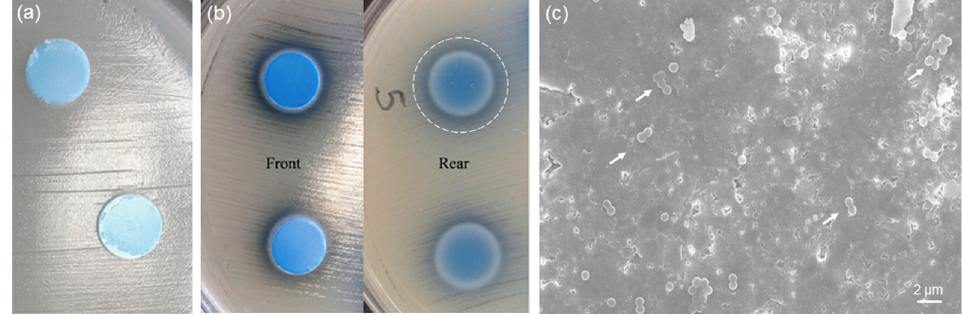
Figure 7. In vitro antibacterial experiments (24 h): inhibition halo tests on ( a ) 1Cu-glass and ( b ) 5Cu-glass; ( c ) SEM micrograph showing the surface of 1Cu-glass after the test (the white arrows highlight the few clusters of bacteria survived).